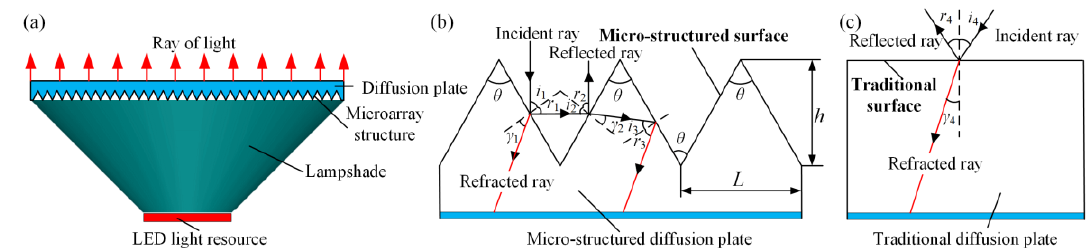
Figure 1. ( a ) Schematic diagram of the LED lamp. ( b ) Optical travel principle of the microstructured diffusion plate. ( c ) Optical travel principle of the traditional diffusion plate.